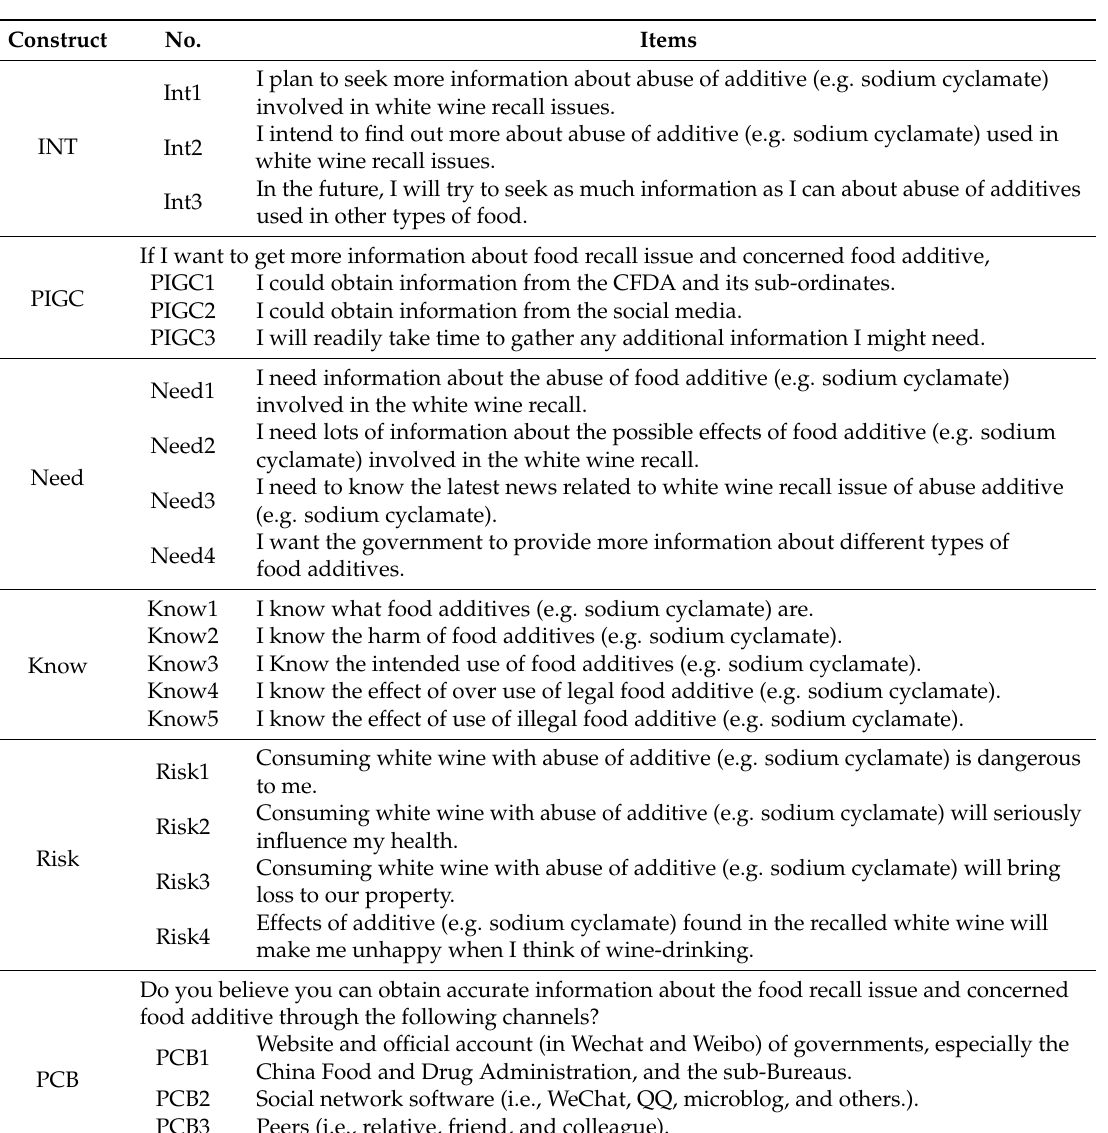
Table A1. Constructs of the proposed